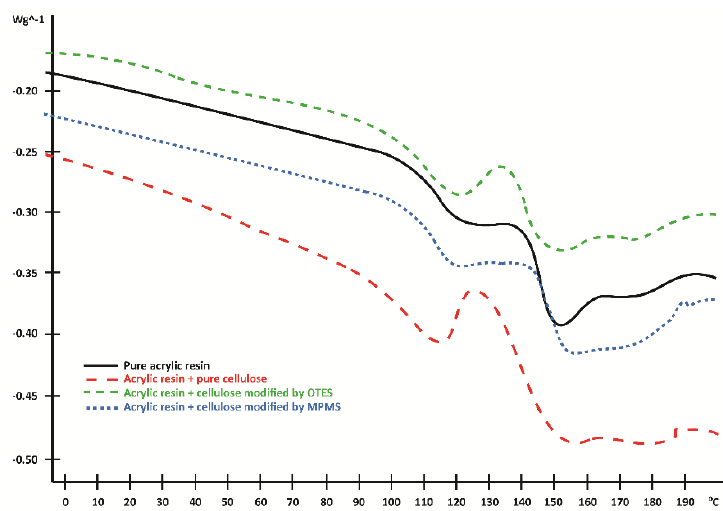
Figure 7. Differential scanning calorimetry (DSC) diagrams of investigated materials.